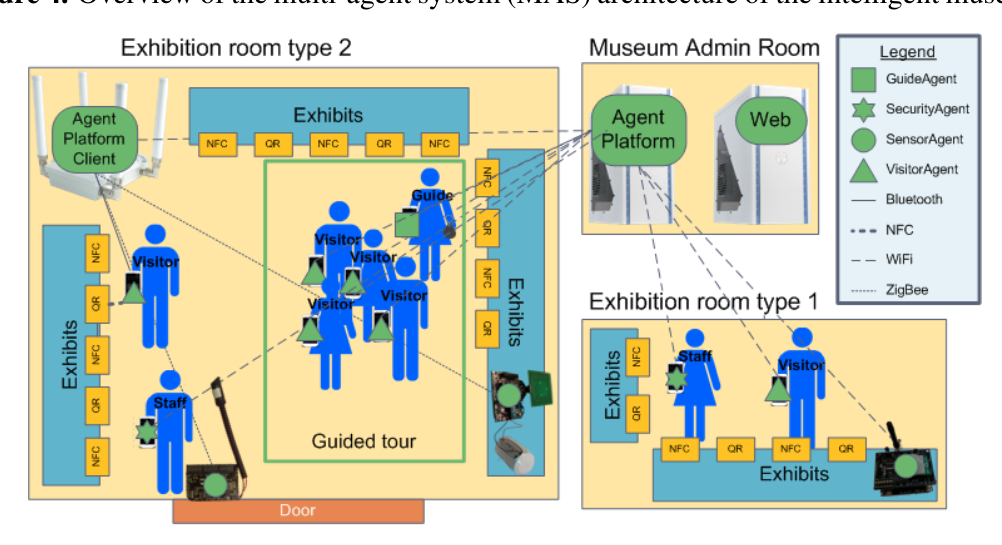
Figure 4. Overview of the multi-agent system (MAS) architecture of the intelligent